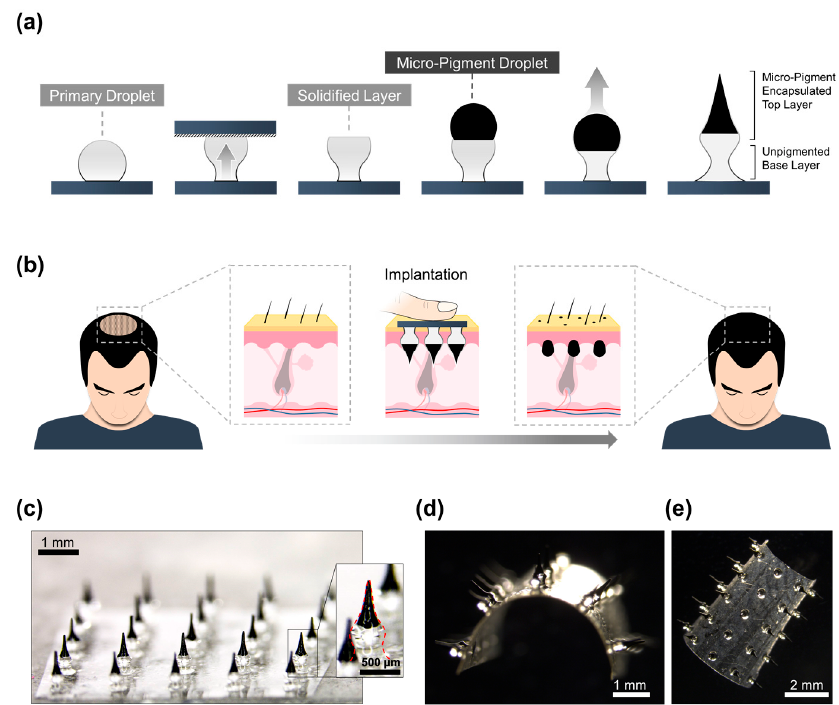
Figure 1. Fabrication and implantation of micro-pigment-encapsulated biodegradable microneedles (PBMs). ( a ) PBMs are fabricated in two phases of (i) unpigmented primary layer, and (ii) micro-pigment-encapsulated secondary layer. Briefly, the unpigmented droplet is dispensed over a thin hyaluronic acid (HA) sheet and centrifuged to form a wine glass-shaped primary layer. The micro-pigment-encapsulated droplet is then dispensed over the solidified primary layer and centrifuged to form PBMs. ( b ) Upon complete implantation, PBMs reside in the dermis layer and reduce the contrast between scalp and hairs. ( c ) A microscopic image of a 5 × 5 PBM array. ( d ) PBMs are fabricated over flexible biodegradable sheets that can be washed off post-implantation. ( e ) Top view of the bent PBM-fabricated flexible sheet.